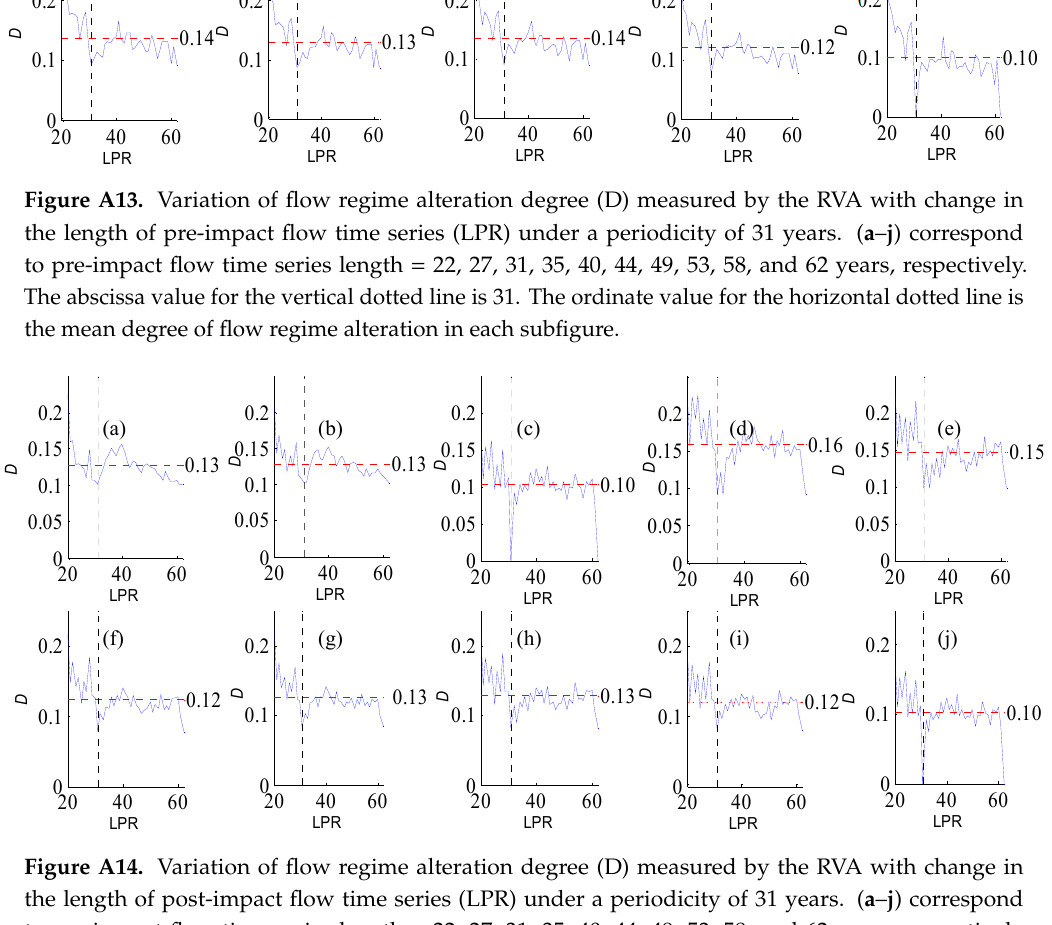
Figure A14. Variation of flow regime alteration degree (D) measured by the RVA with change in the length of post-impact flow time series (LPR) under a periodicity of 31 years. ( a ), ( b ), ( c ), ( d ), ( e ), ( f ), ( g ), ( h ), ( i ), and ( j ) correspond to pre-impact flow time series length = 22, 27, 31, 35, 40, 44, 49, 53, 58, and 62 years, respectively. The abscissa value for the vertical dotted line is 31. The ordinate value for the horizontal dotted line is the mean degree of flow regime alteration in each subfigure.